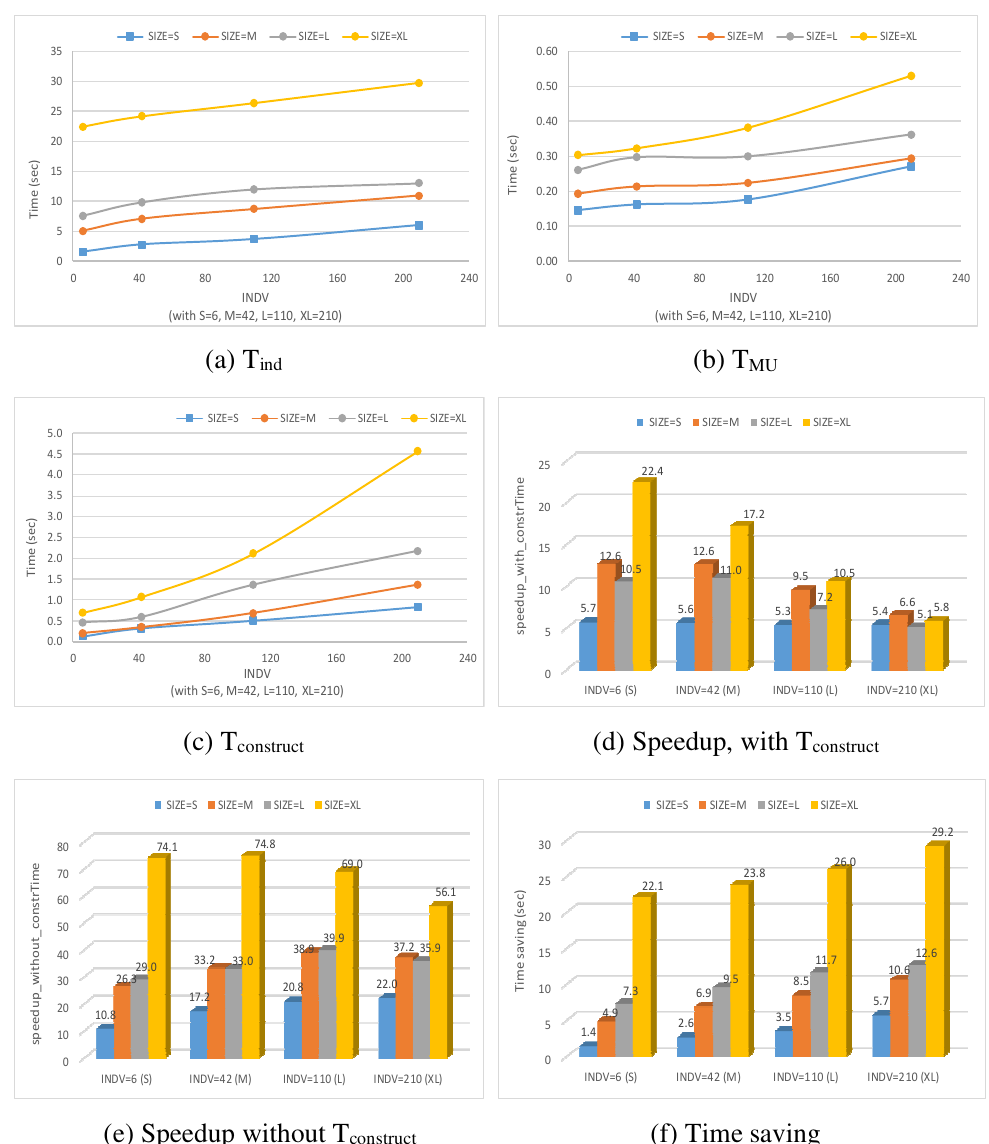
Figure 26. Results for trend analysis (RT2) for all INDV and SIZE